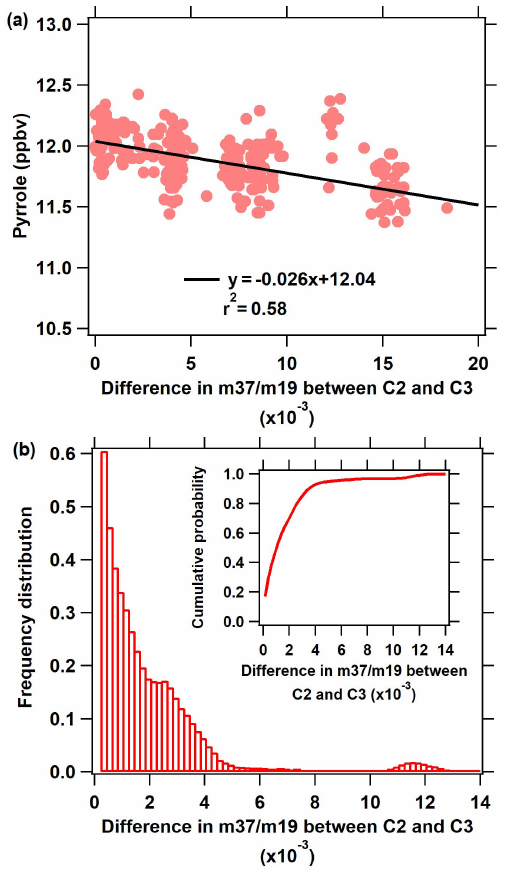
Figure 7. (a) Pyrrole concentration during zero air measurements (C2) as a function of the difference in m37 / m19 between the C2 and C3 humidity indicator (m37 / m19). (b) Frequency distribution of the difference in m37 / m19 between C2 and C3 during the mea-